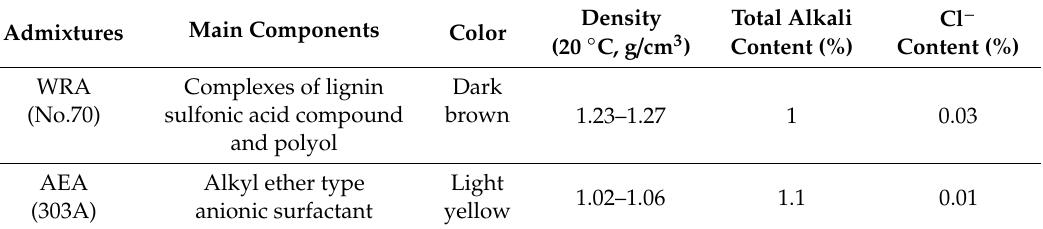
Table 2. Properties of admixtures.